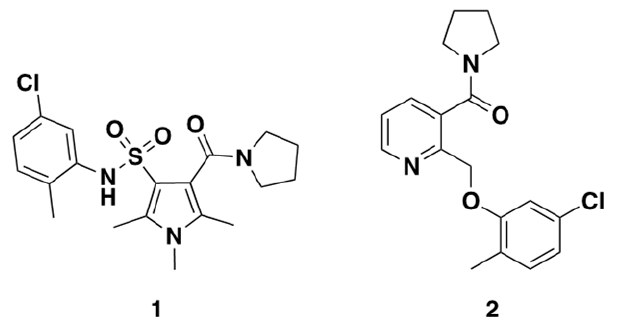
Figure 7. Chemical structures of 1 and 2 .